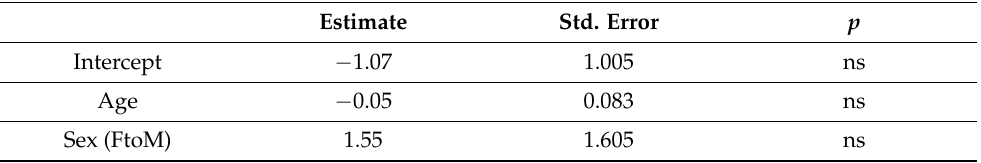
Figure 3. Number of times individuals showed prosocial behavior during 10 min Zoom session, as a function of individual age and sex of the individual and Zoom partner, with trendlines and 95% confidence intervals. ( Left ) panel shows males in Zoom sessions with female (dashed) or male (solid) partners. Young males in sessions with other males showed more prosocial behavior than older males in sessions with females. ( Right ) panel shows females in Zoom sessions with female (solid) or male (dashed) partners. Females tended to show more prosocial behavior toward a male partner than a female partner, regardless of female age. Table 3. Estimates from the Poisson regression for the number of times an individual showed pro- social behavior during the 10 min Zoom session.